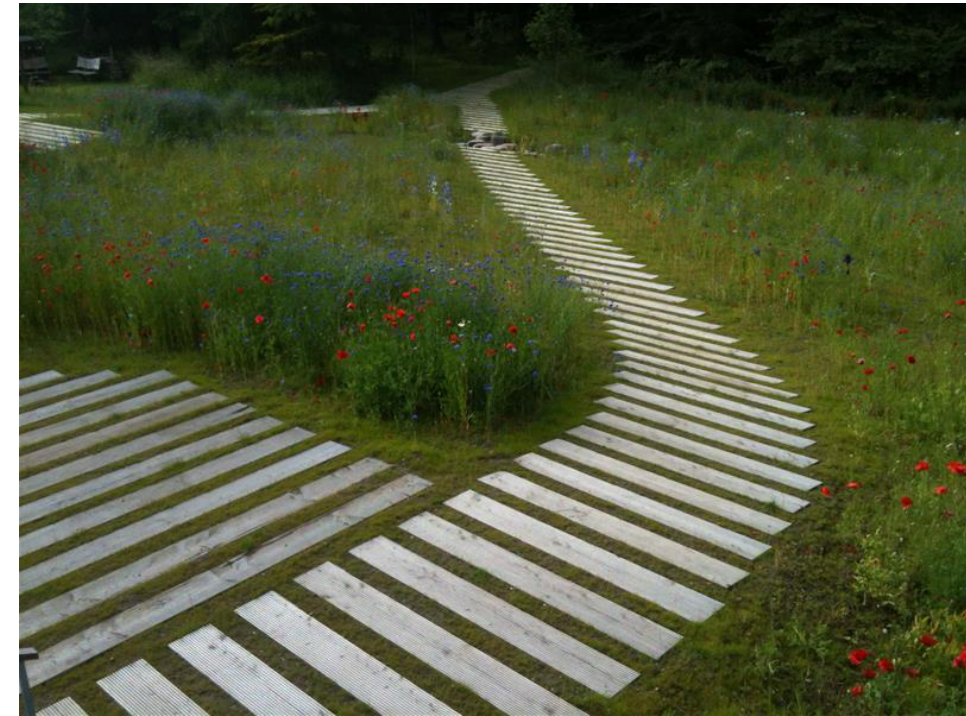
Figure 5. Nacadia Healing Garden, Denmark.